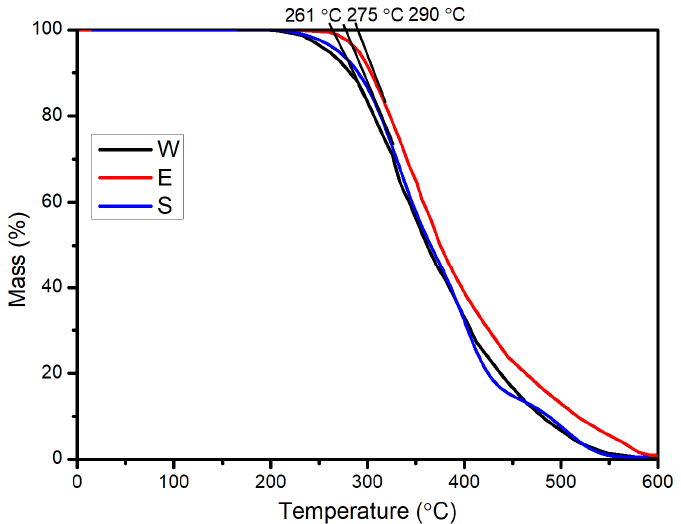
Figure 2. Thermal stability of the three kinds of healing agents (sunflower oil (S), engine oil (E), waste cooking oil (W)). Capillaries with a length of 100 mm and an inner diameter of 200 μ m were used to test the capillary flow of the different healing agents. The three kinds of healing agents were each filled in glass dishes that had a diameter of 100 mm at 15 °C. During the test process, one end of the capillary was inserted vertically into the healing agent. The whole experiment lasted for 1 min and the capillary remained stationary. One minute later, the height of the healing agent in the capillary was measured with vernier calipers.